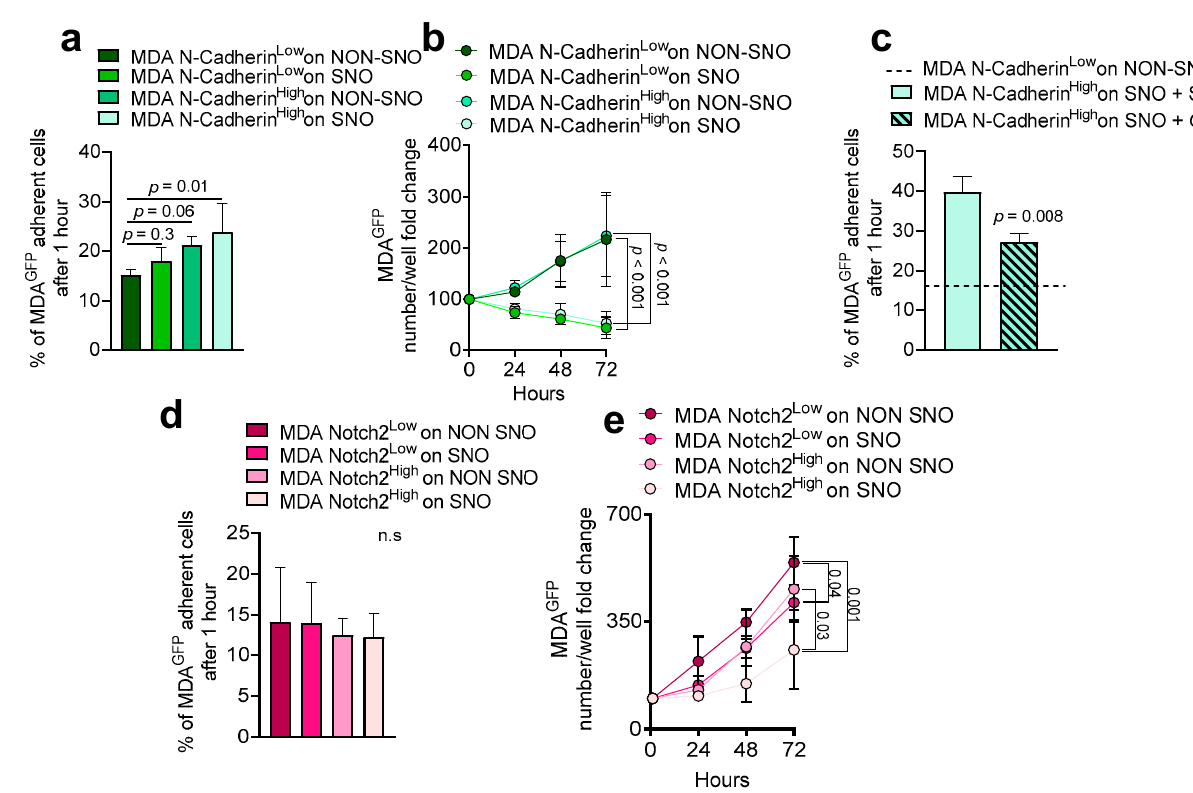
Figure 3. Role of N-Cadherin and Notch2 in MDA-SNO interaction in vitro. ( a ) N-Cadherin High and N-Cadherin Low MDA GFP cells were seeded onto MACS-sorted SNOs and NON-SNOs and allowed to attach for 1 h at 37 ◦ C, followed by extensive washing. Number of MDA GFP cells was assessed after 1h of adhesion and ( b ) after 24–72 h of co-culture. ( c ) N-Cadherin High and N-Cadherin Low MDA GFP cells, treated with siRNA against the N-Cadherin (CDH2-siRNA) or scrambled (SCR-siRNA), were seeded onto MACS-sorted SNOs and NON-SNOs. The number of MDA GFP cells was assessed after 1h of adhesion. ( d ) Notch2 High and Notch2 Low MDA GFP cells were seeded onto MACS-sorted SNOs and NON-SNOs and allowed to attach for 1 h at 37 °C, followed by extensive washing. The number of MDA GFP cells was assessed after 1h of adhesion and ( e ) after 24–72 h of co-culture. In ( b , d ) cell number per well was normalized for time 0 (number of cells after 1 h of adhesion). Data are the mean ± SD of 4 independent cell preparations. Statistical analysis: ( a , c , d ) Student’s t-test, ( b , e ) Non-linear regression fitting and F-test.